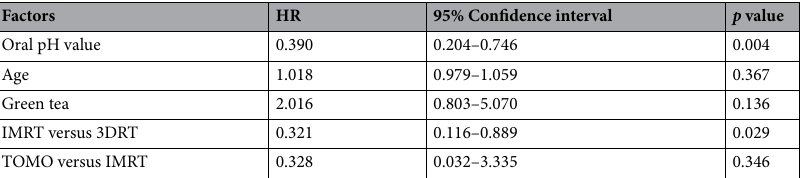
Table 3. Idenidentification of risk factors for radiation-related caries by multivariate analysis. HR Hazard ratio, IMRT Intensity-modulated radiotherapy, 3DRT 3D conformal radiotherapy, TOMO Tomotherapy.